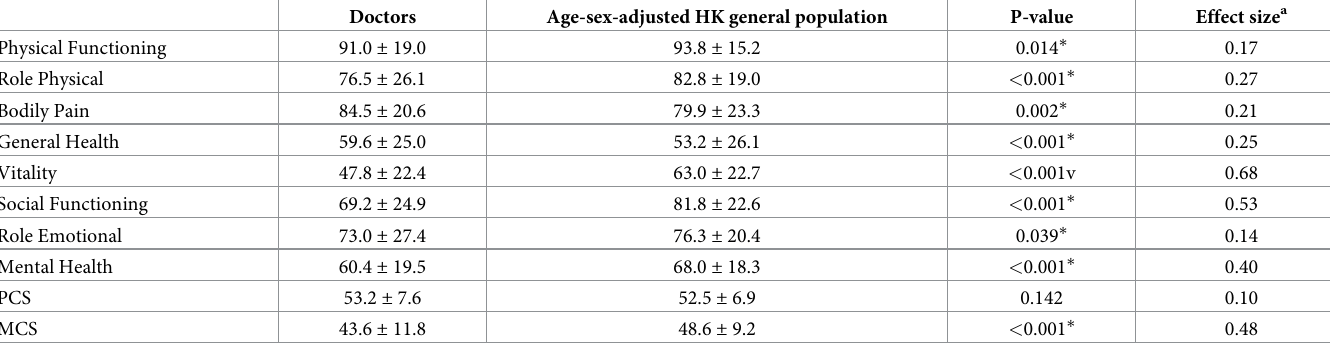
Table 2. Comparison of SF-12v2 domains, PCS, and MCS between doctors and age-sex-adjusted HK general